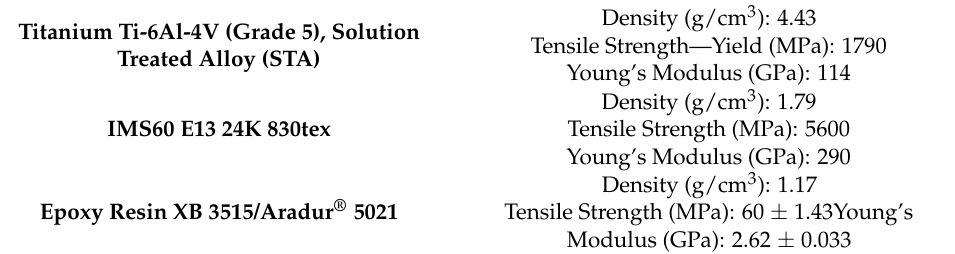
Table 1. Materials data